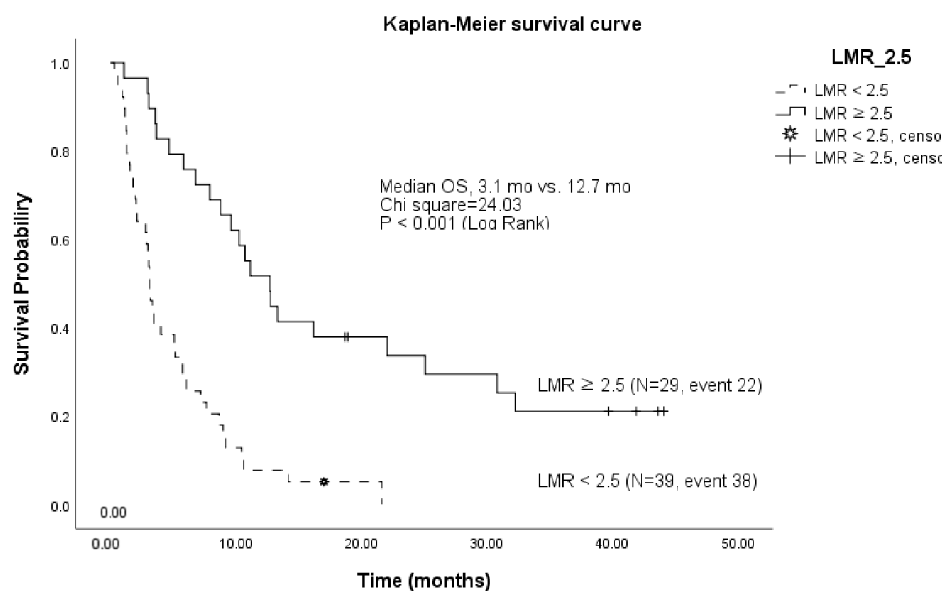
Figure 4. Kaplan–Meier survival curve of lymphocyte-to-monocyte ratio (LMR). Cut-off = 2.5. LMR, lymphocyte-to-monocyte ratio; mo, months. lymphocyte-to-monocyte ratio; mo, months.